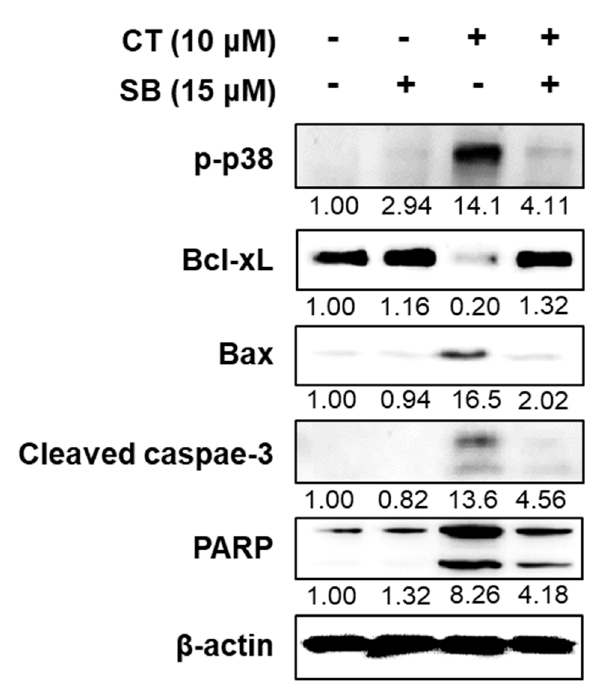
Figure 6. Effect of CT and a p38 inhibitor on apoptotic factors. Western blot using HL-60 cells treated with CT (10 μ M) and/or SB203580 (SB, 15 μ M) for 6 h to assess phospho-p38 (p-p38) and apoptotic proteins, including Bcl-xL, Bax, cleaved caspase-3, and poly (ADP-ribose) polymerase (PARP). β -Actin was used as the loading control. The relative band intensity of proteins to that of β -actin is expressed as the fold change compared to the control (no treatment) and is indicated below each band.